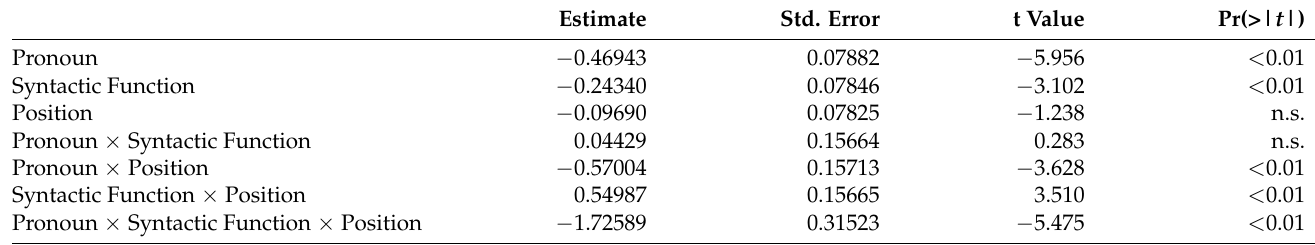
Figure 3. Mean acceptability in Experiment 3. Error bars show 95% confidence intervals. Table 6. Ordinal mixed model for Experiment